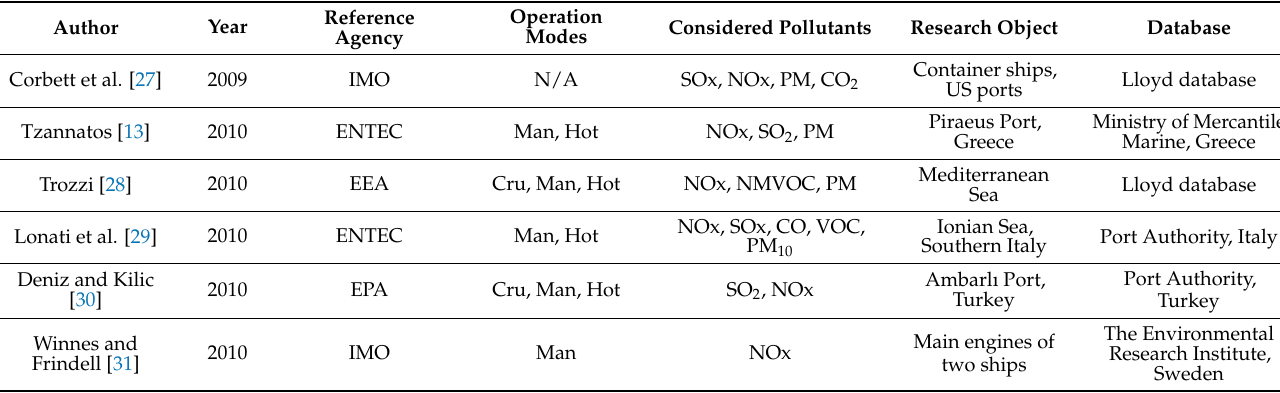
Table 1. Summary of bottom-up approach